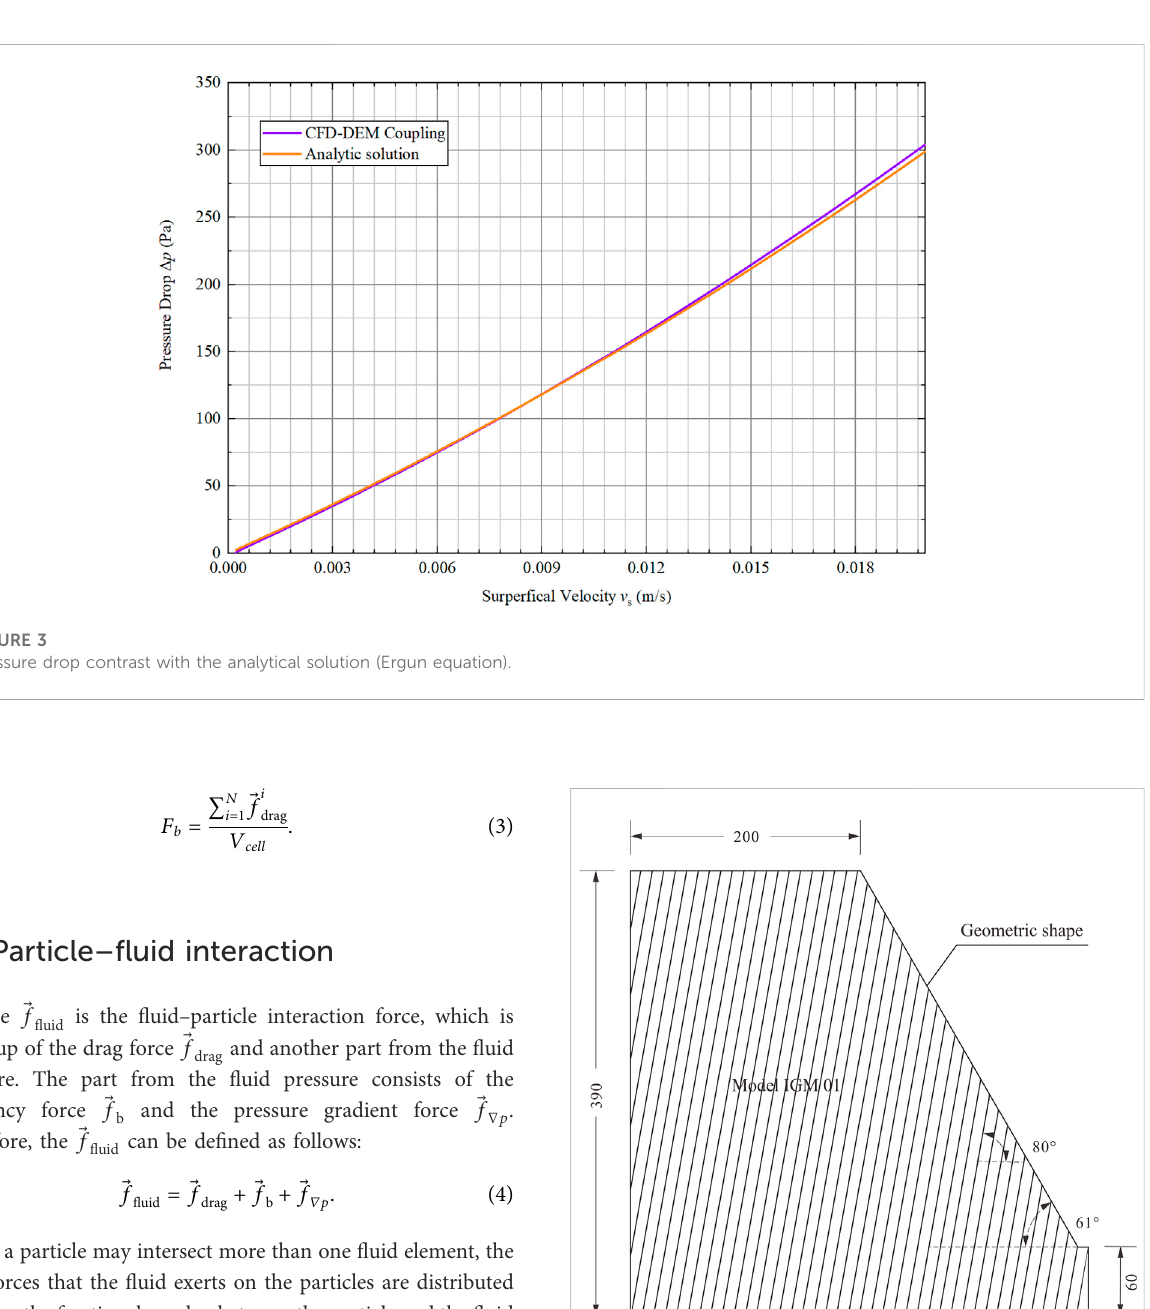
FIGURE 4 Geometrical details of Model IGM 01 (unit: